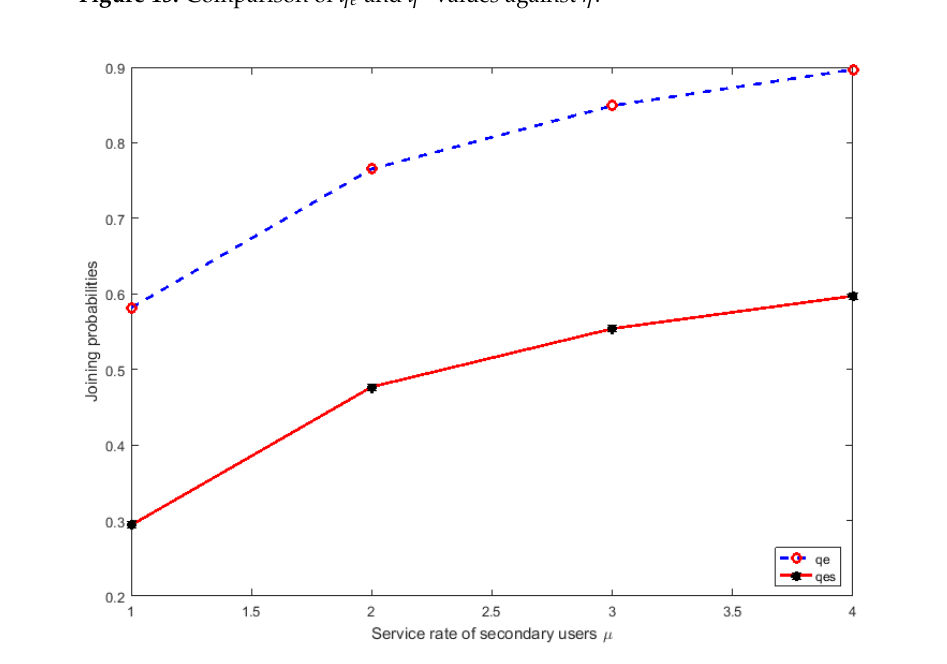
Figure 16. Comparison of q e and q ∗ values against µ